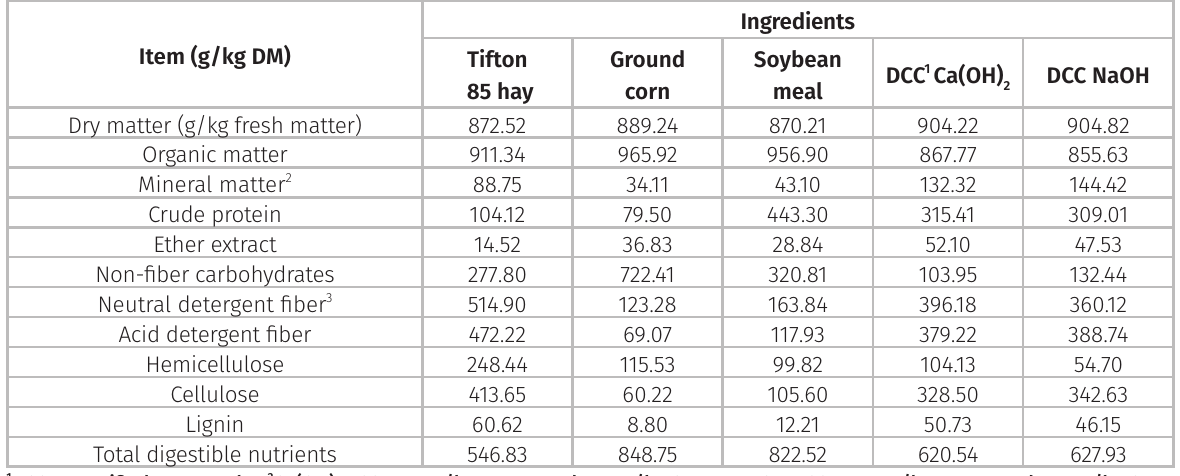
Table I. Chemical composition of the ingredients used for the preparation of the experimental